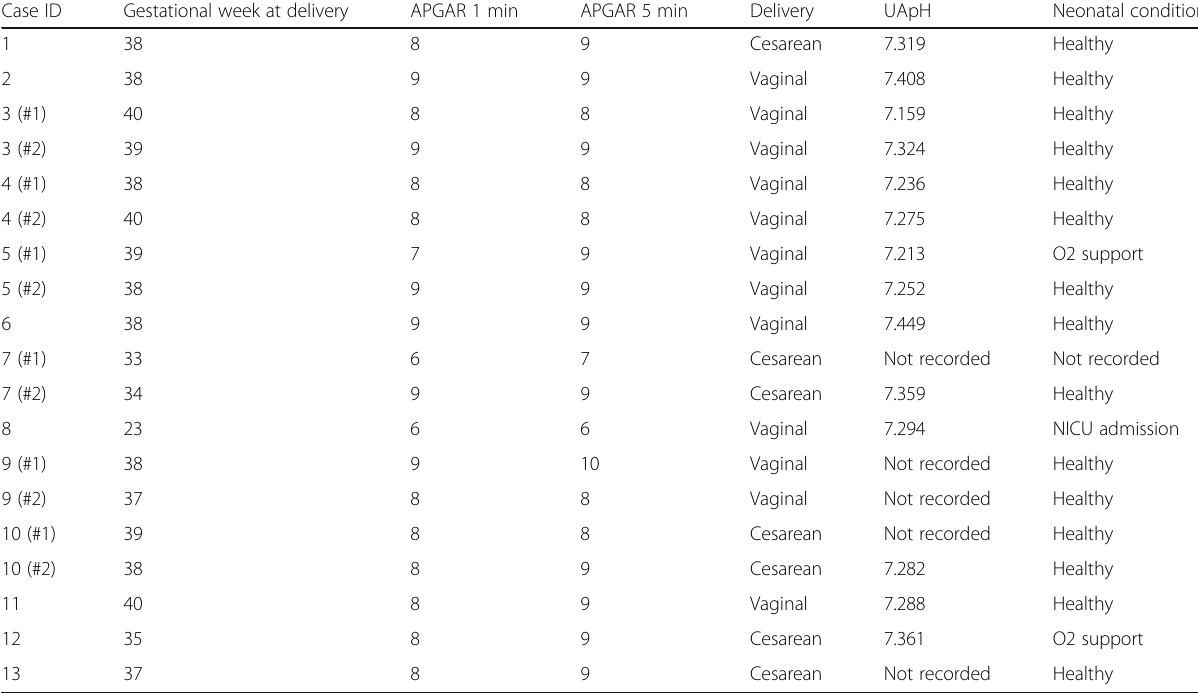
Table 3 Neonatal